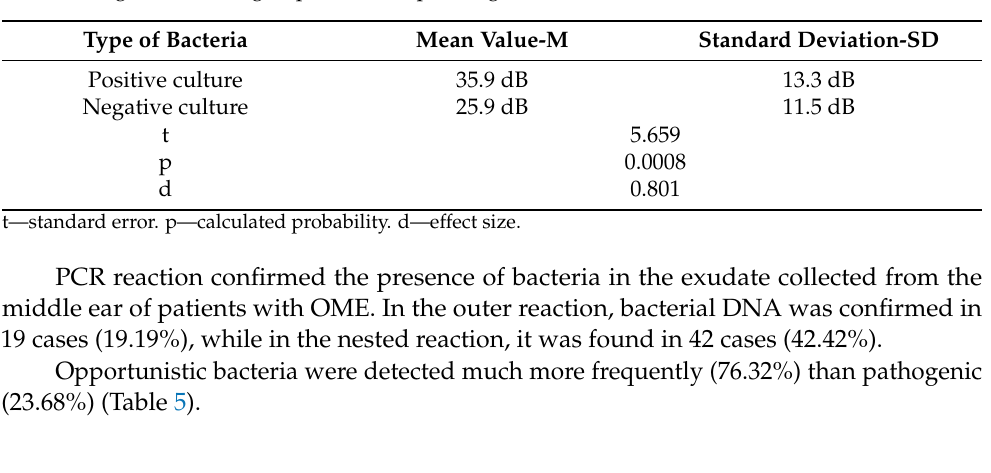
Table 4. Degree of hearing impairment depending on the culture